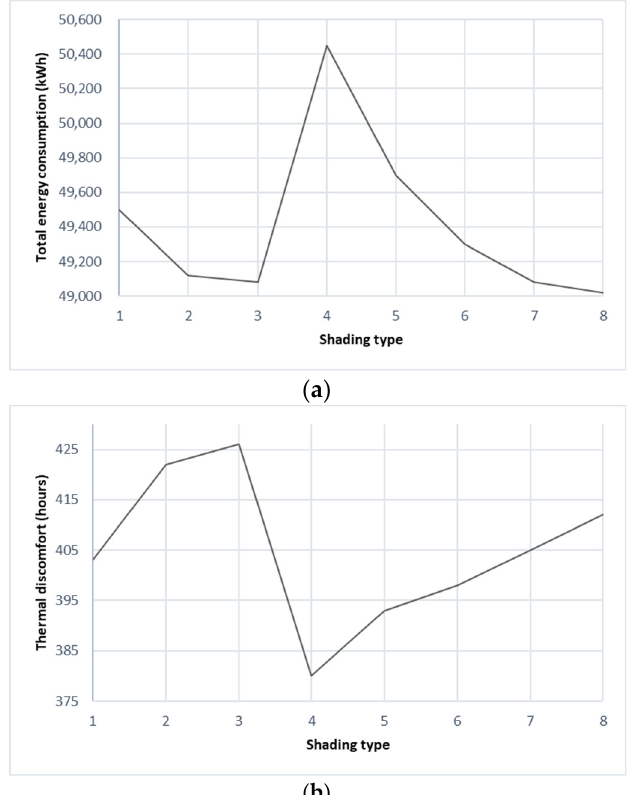
Figure 11. The effect of shading types on ( a ) energy consumption ( b ) students’ thermal discomfort hours. Legend. 1: 0.5 projection Louvre, 2: 1.0 projection Louvre, 3: 1.5 projection Louvre, 4: No shading, 5: 0.5 m Overhang, 6: 1.0 m Overhang, 7: 1.5 m Overhang, 8: 2.0 m Overhang.